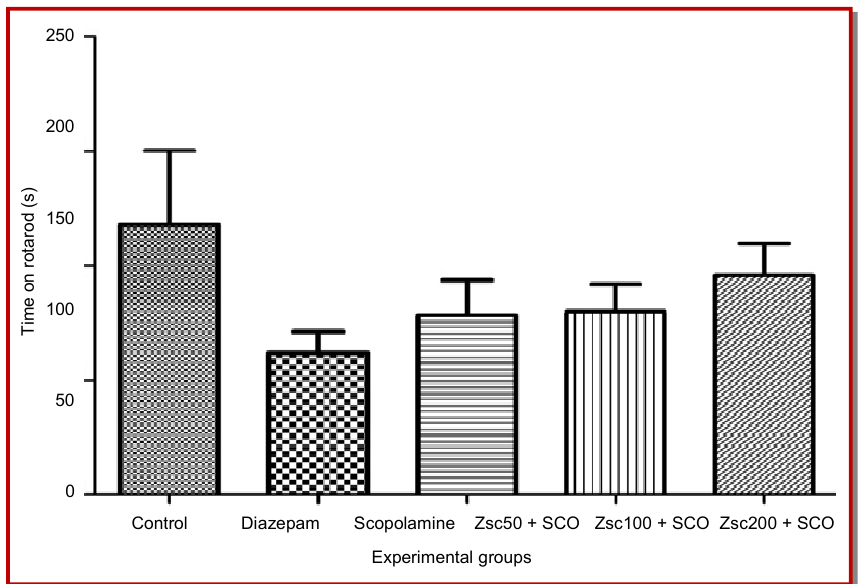
Figure 2: Means ± SEM of rod descent latency following rotarod test